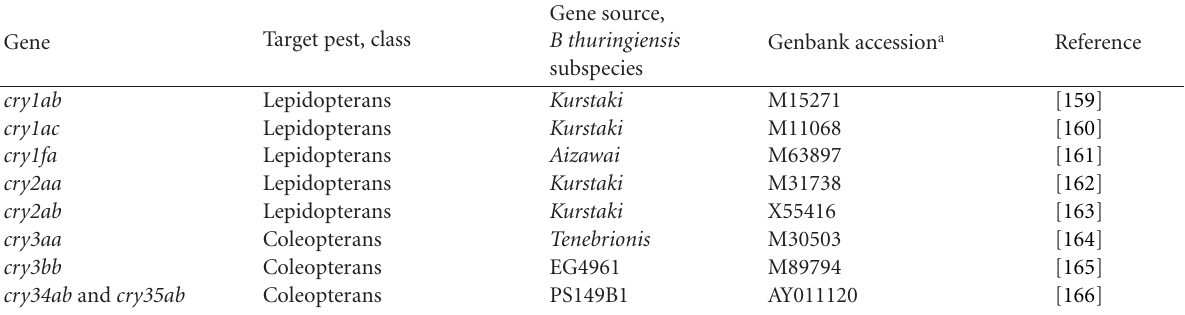
Table 4. cry transgenes present in GM crops that have been approved for food